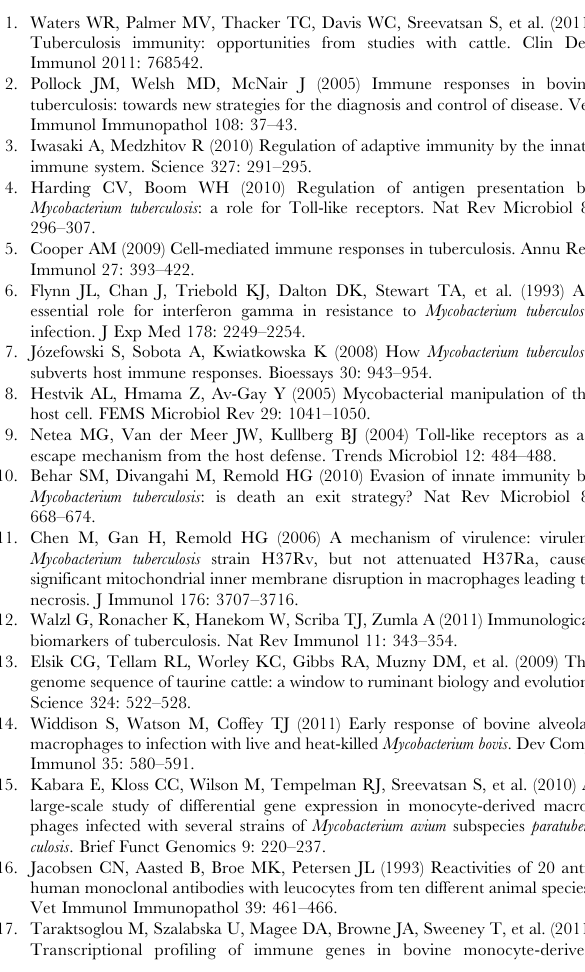
challenge. The top ranking GO categories identified by IPA are listed according to P -values. Table S10 Top-ranking canonical pathways identified using IPA at the 24 hour time point post- M. bovis challenge. The top ranking canonical pathways identified by IPA are listed according to P -values. The ratio indicates the number of differentially expressed genes involved in each canonical pathway divided by the total number of genes within each pathway according to the IPA Knowledge Base. Table S11 Comparison of relative gene expression fold- changes in the M. bovis -challenged MDM obtained from real time qRT-PCR analysis using conventionally-pre- pared and linearly amplified cDNA. Geometric mean fold- changes in gene expression ( M. bovis -challenged MDM versus control MDM) are given. P -values were obtained by statistical analysis of log 2 fold-change gene expression data. Table S12 Comparison of fold-changes in gene expres- sion in the M. bovis -challenged MDM based on micro- array and real time qRT-PCR results. Geometric mean fold-changes of gene expression ( M. bovis -challenged MDM relative to control MDM) are given for the microarray and